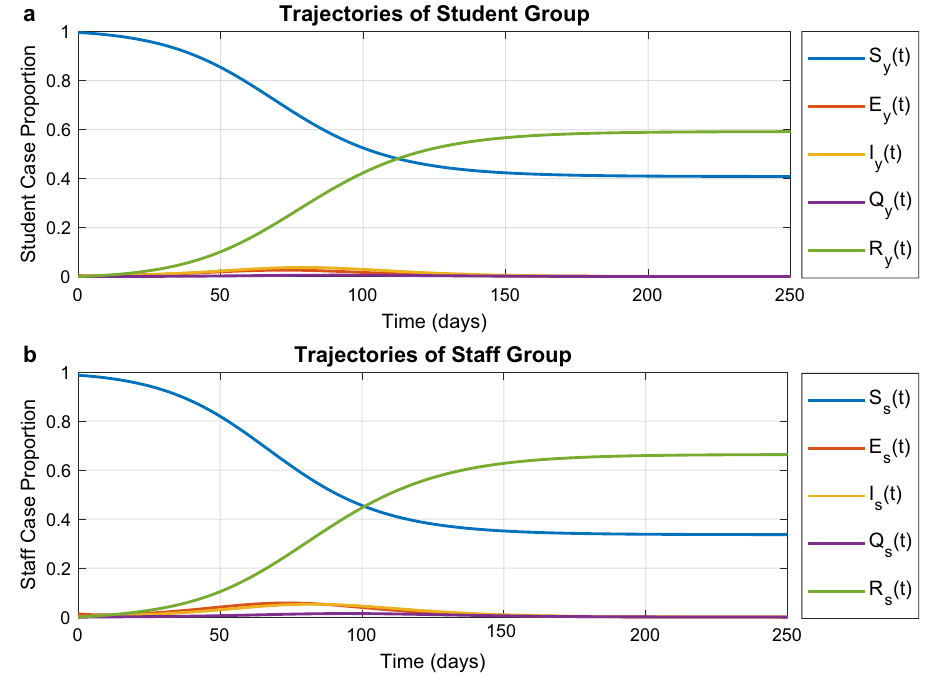
Figure 2. Prediction in the baseline scenario of no interventions. ( a ) Evolution of COVID-19 among students. ( b ) Evolution of COVID-19 among staff. Magnitudes are in proportion to the total number of students or